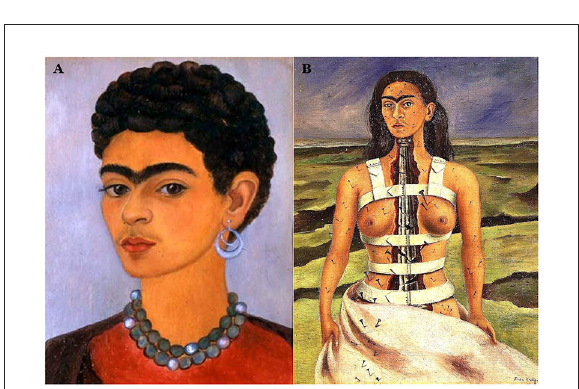
FIGURE6 These two portraits (A) ” Self-portrait with curly-hair” (1935) and (B) “The broken column” (1944) represent the two extremes in terms of canvas structuring in Frida Kahlo’s art. The first, inspired by Roman-Egyptian portraits, uses simple superposition of tones to convey the stern but dignified outrage of Frida toward the betrayal of her husband with her closest confidante, her sister Cristina. Note the cropped hair that was drawn in protest of Diego who liked her long hair (Lozano et al., 2021, p. 511). The second one, inspired by Greek architecture as by the ionic column standing for her damaged spine, is instead a highly structured piece. High FD quantifies the complexity of the color structure on canvas. This piece has been critically acclaimed